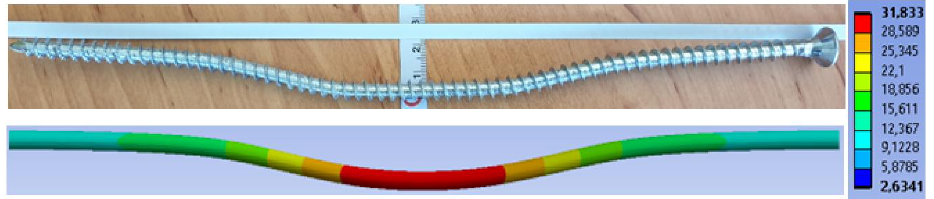
Figure 28. Deformation of a fully threaded screw (mm).